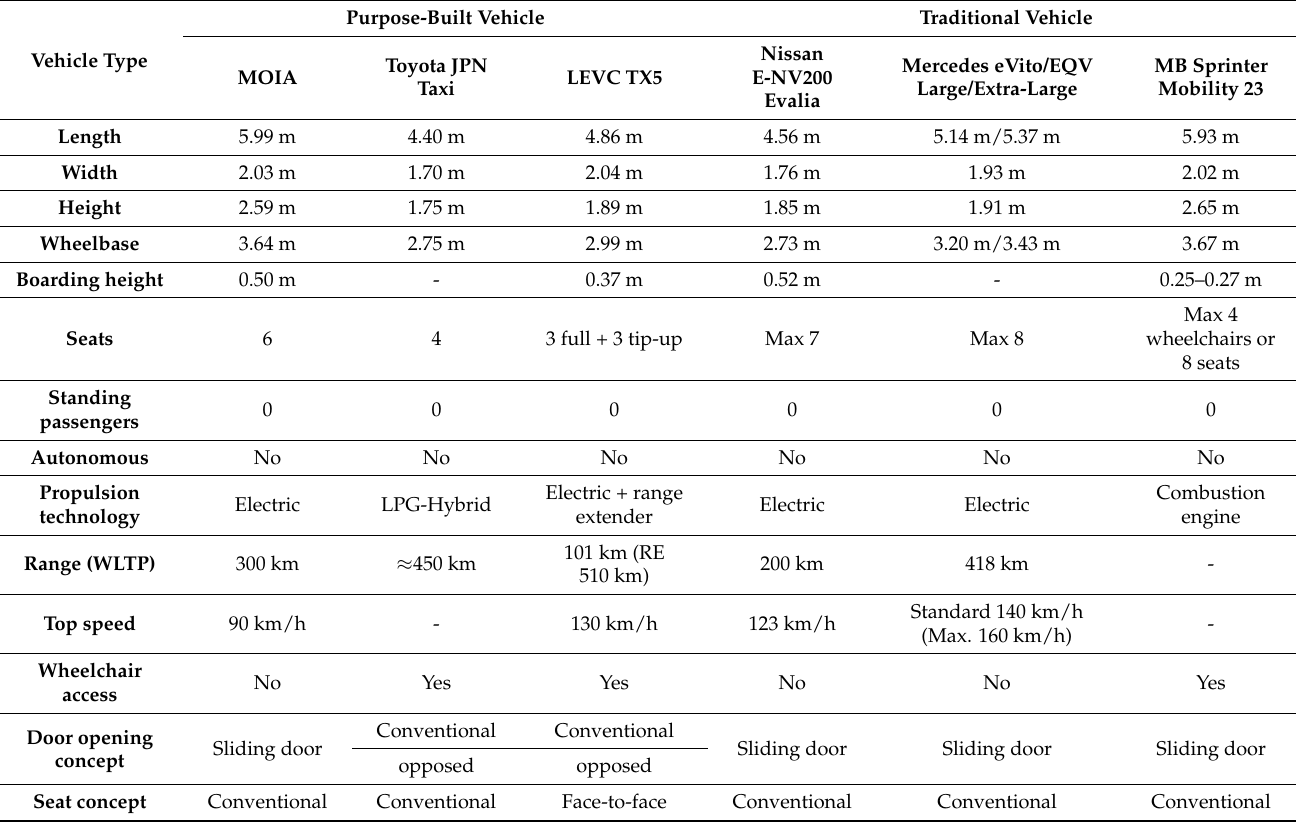
Table 1. Comparison of currently available and frequently-used vehicles for on-demand mobility services in Germany. In addition, the Toyota JPN Taxi (only available in Japan) was included in the comparison because it is advertised as being particularly